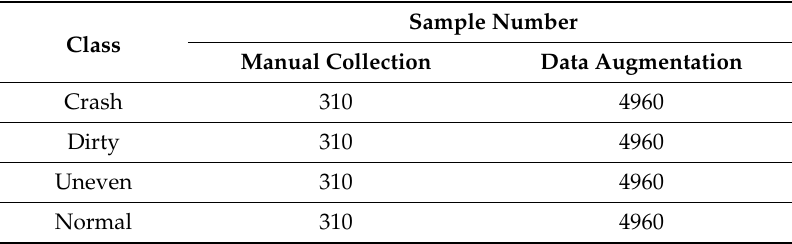
Table 3. Private CSB defect dataset.